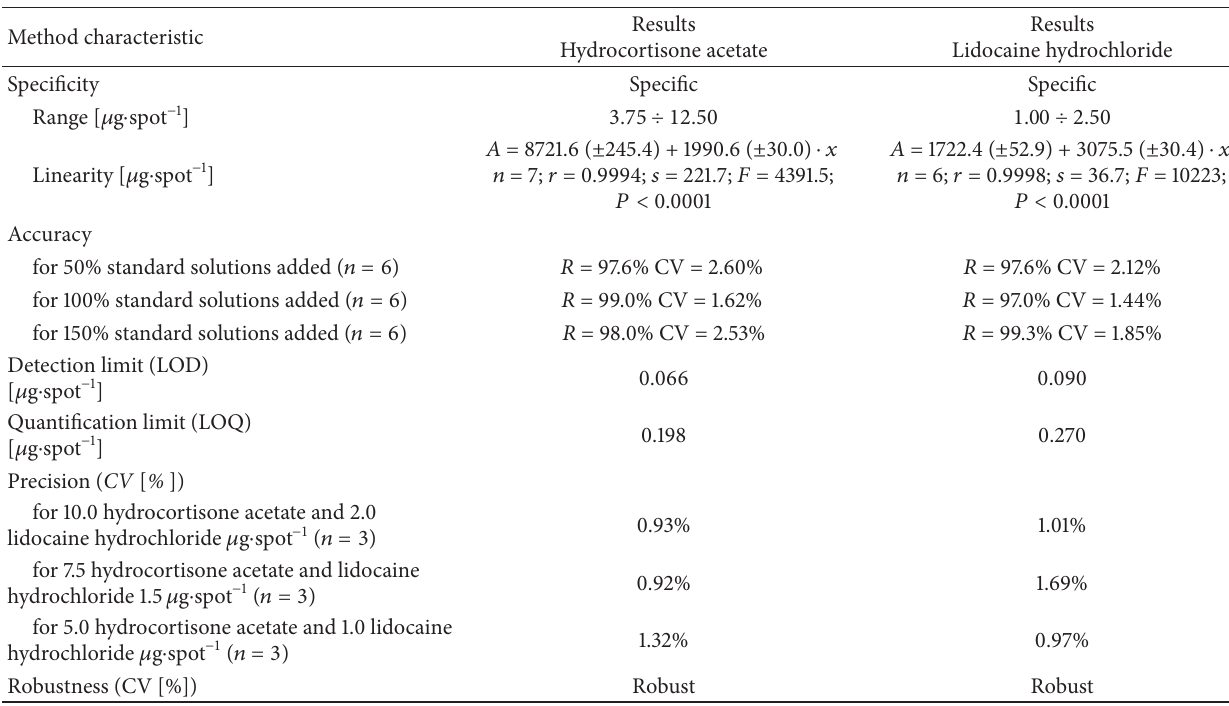
Table 2: Validation of the method. Data for the quantitative determination of hydrocortisone acetate and lidocaine hydrochloride by NP-TLC with densitometry a .